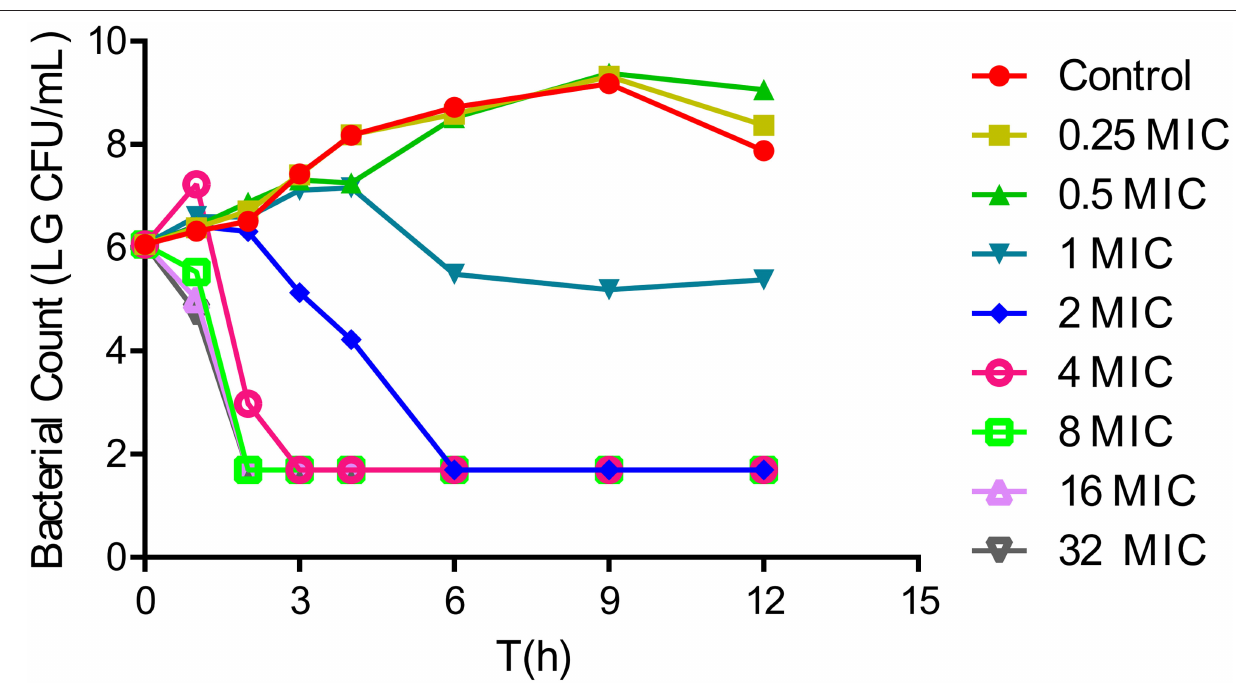
FIGURE 1 | In vitro time-kill curves for tulathromycin against Actinobacillus pleuropneumoniae CVCC259 in tryptic soy broth (TSB) (containing 1% NAD (1 mg/ml) and 4% newborn calf serum).